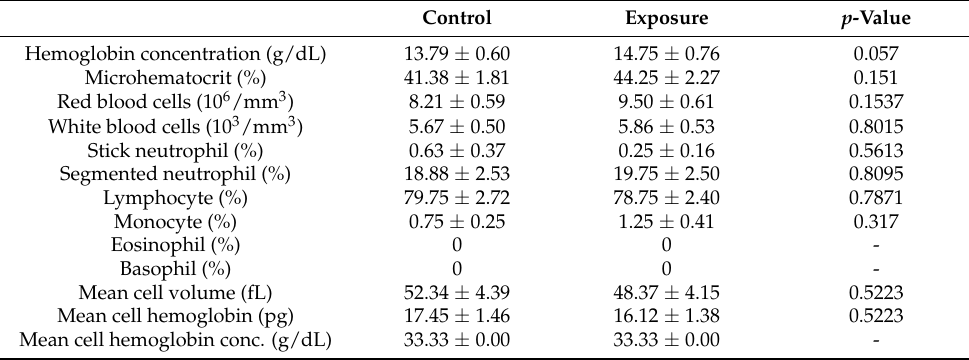
Table 2. Blood parameters. Results expressed in mean ± standard error.